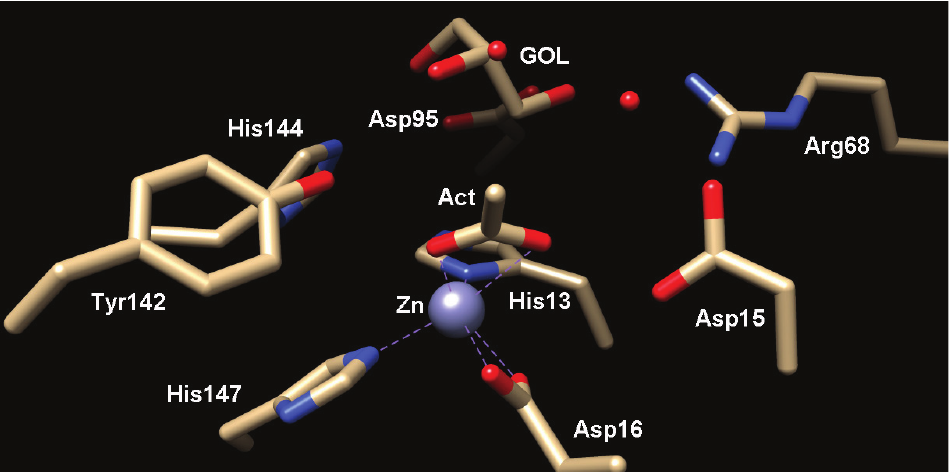
Figure 5. Active site of MshB (PDB 4EWL) containing bound glycerol (GOL) and acetate (Act) molecules. The catalytic Zn 2+ ion is represented as a gray